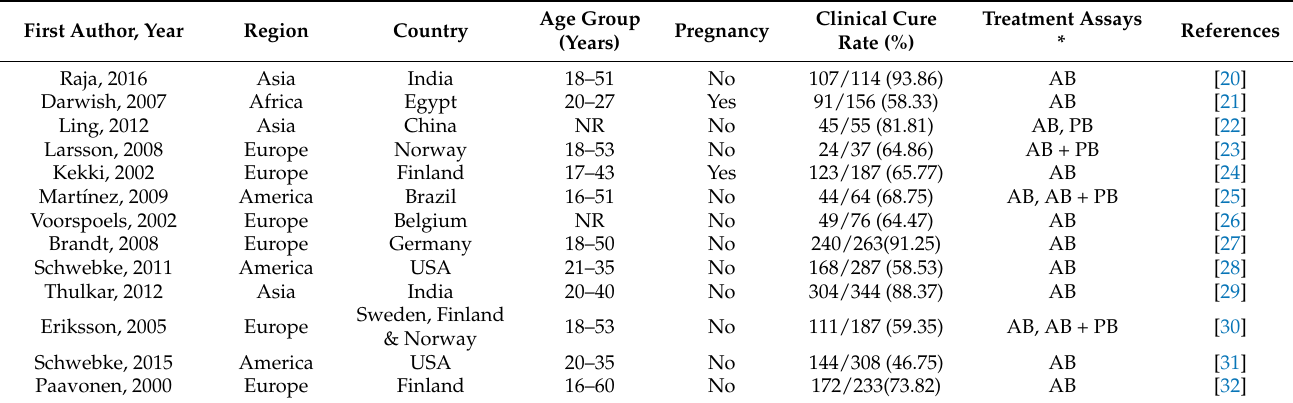
Table 1. General information extracted from the data set and selected for the present meta-analysis.